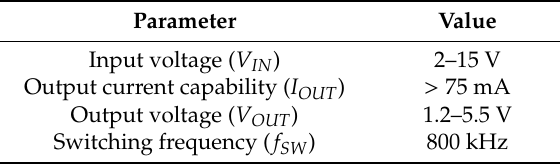
Table 3. Summary of TPS62122 characteristics.